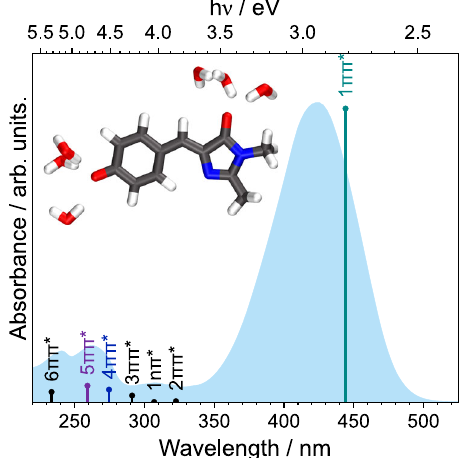
Fig. 1 UV – vis absorption spectrum of 20 μ M aqueous solution of p -HBDI − (blue). Vertical lines mark XMCQDPT2/SA(10)-CASSCF(16,14)/ (aug)-cc-pVDZ//EFP calculated vertical excitation energies (VEEs) with heights proportional to oscillator strengths. Inset: PBE0/(aug)-cc-pVDZ// EFP(253) equilibrium geometry of p -HBDI − + 6H 2 O. In the depiction of the equilibrium geometry, carbon atoms are shown in black, oxygen atoms in red, nitrogen atoms in blue and hydrogen atoms in